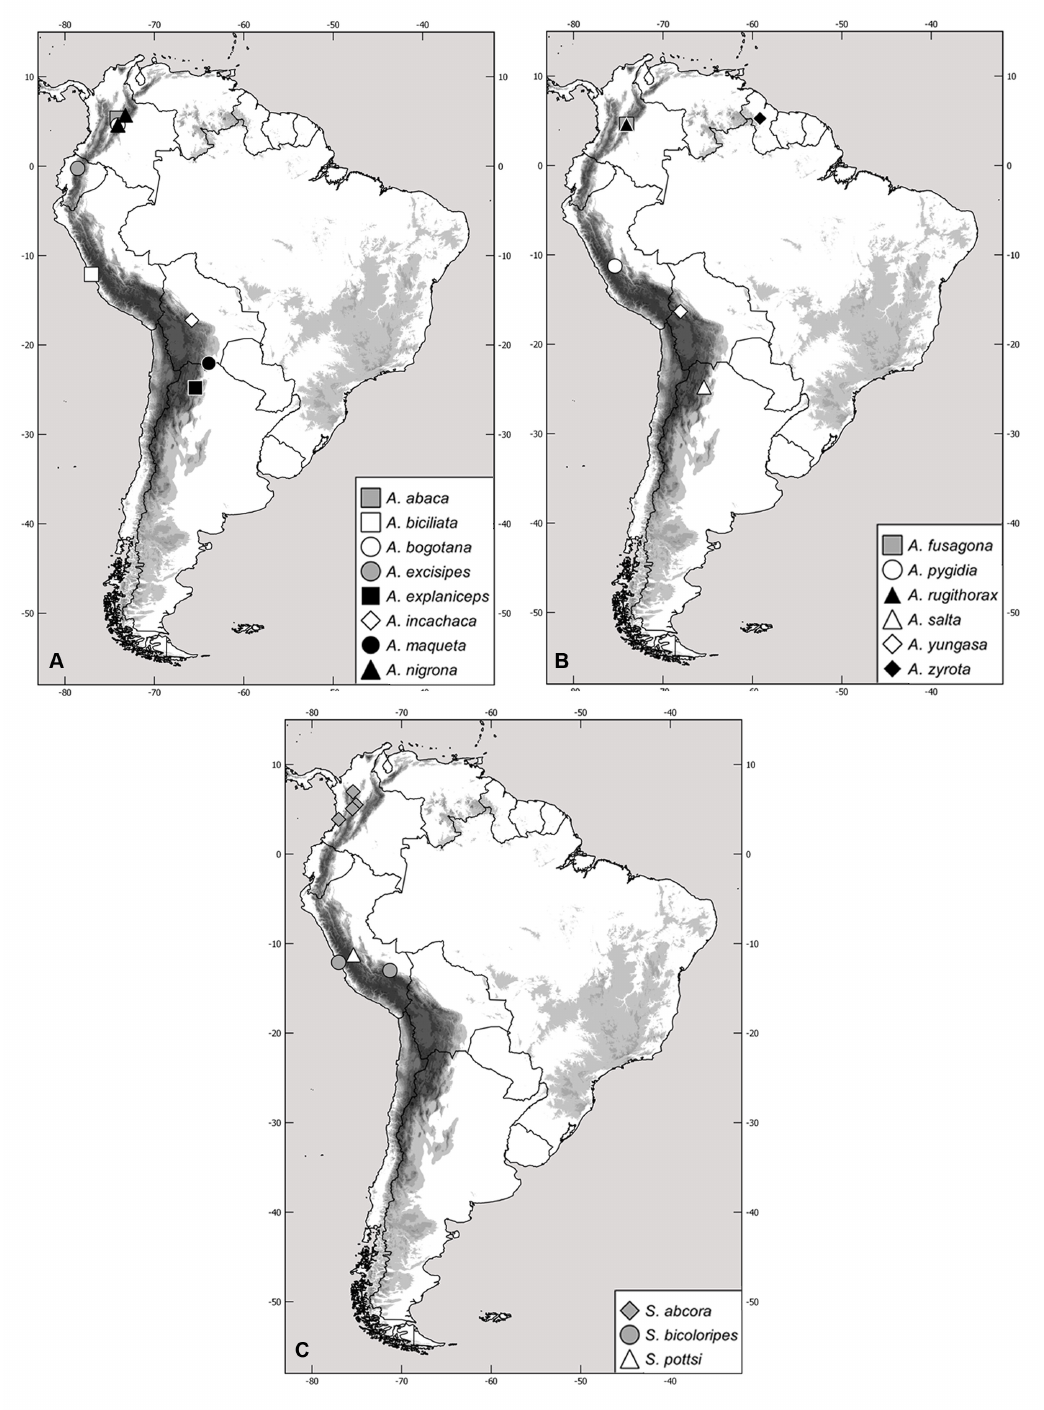
Fig. 7. Distribution of type localities of the South American Sericini species described by